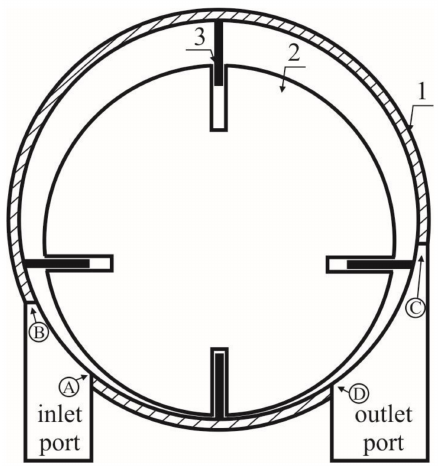
Figure 6. The cross section of the multi-vane expander at 0 ◦ crank angle. (1) cylinder; (2) rotor; (3)